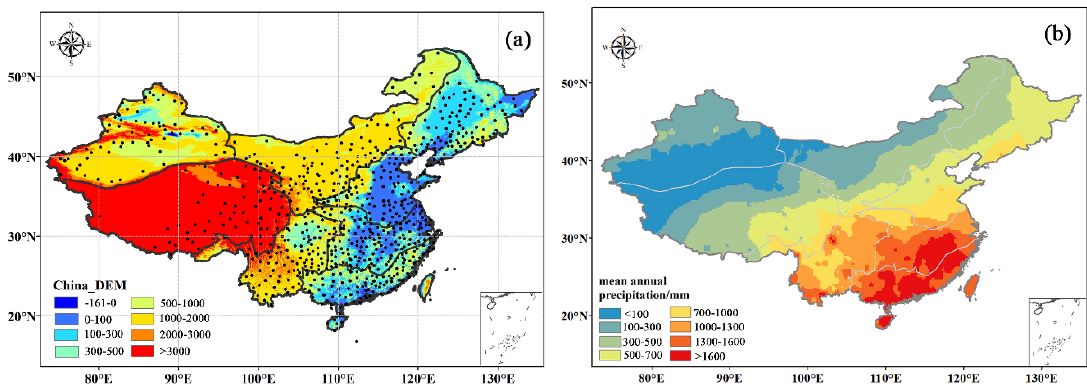
Figure 1. ( a ) The locations of the 774 rain gauge stations plotted on a digital elevation model of China showing different subareas: (I) Northeast China (NE), (II) Northern China (NC), (III) the middle and lower reaches of the Yangtze River region (CJ), (IV) South China (SC), (V) Northwest China (NW), (VI) Southwest China (SW), (VII) Xinjiang, and (VIII) the Tibetan Plateau (TP). ( b ) The spatial distribution of the mean annual precipitation across China.